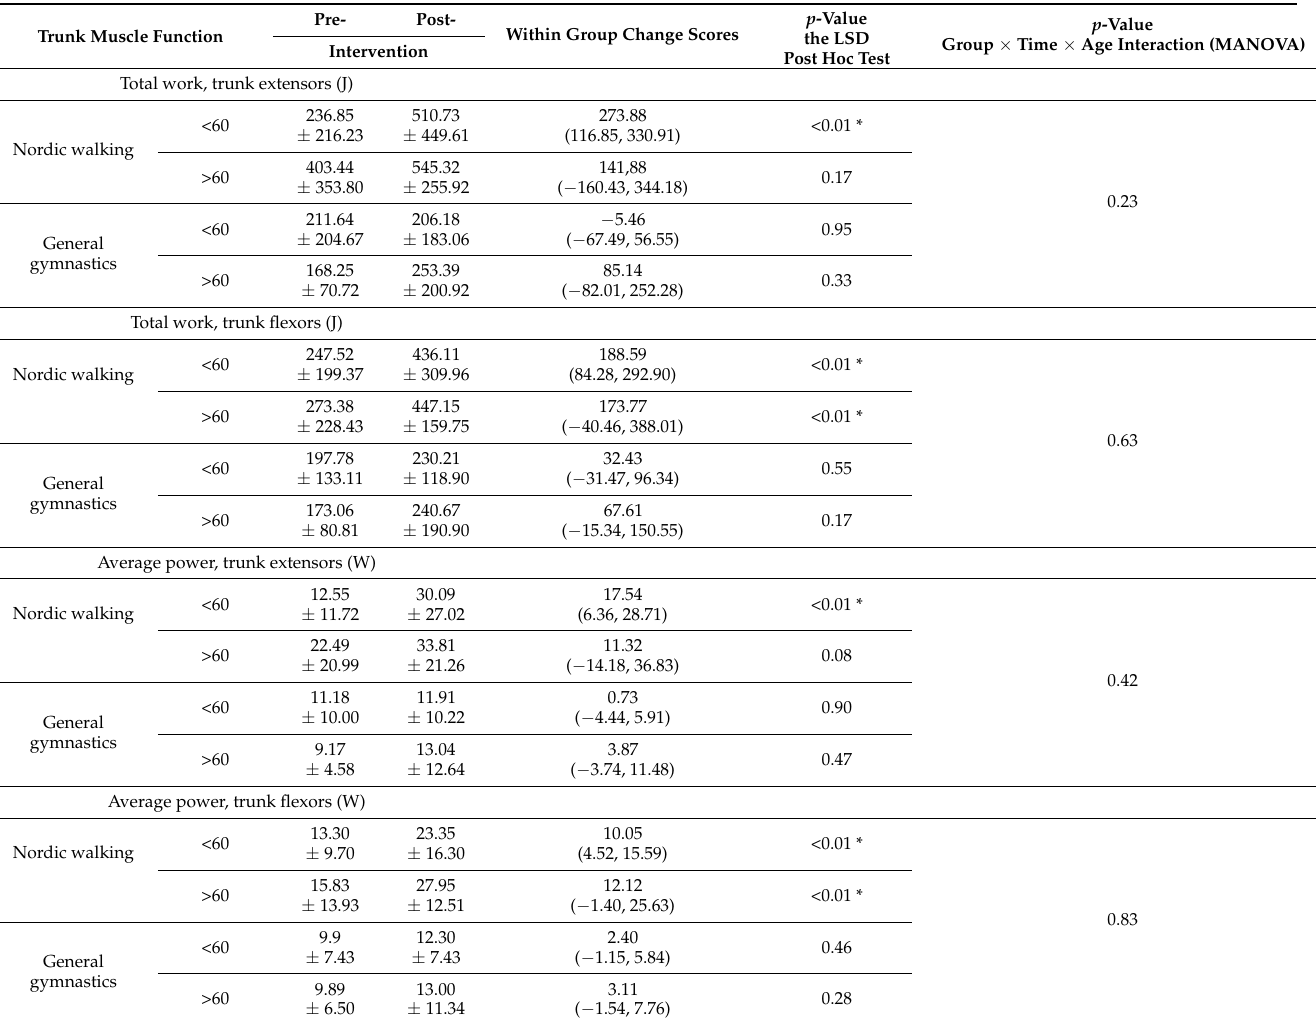
Table 5. Pre- and post-training intervention changes in strength-velocity parameters of the trunk muscle. Pre- Post- Within Group Change Scores Trunk Muscle Function